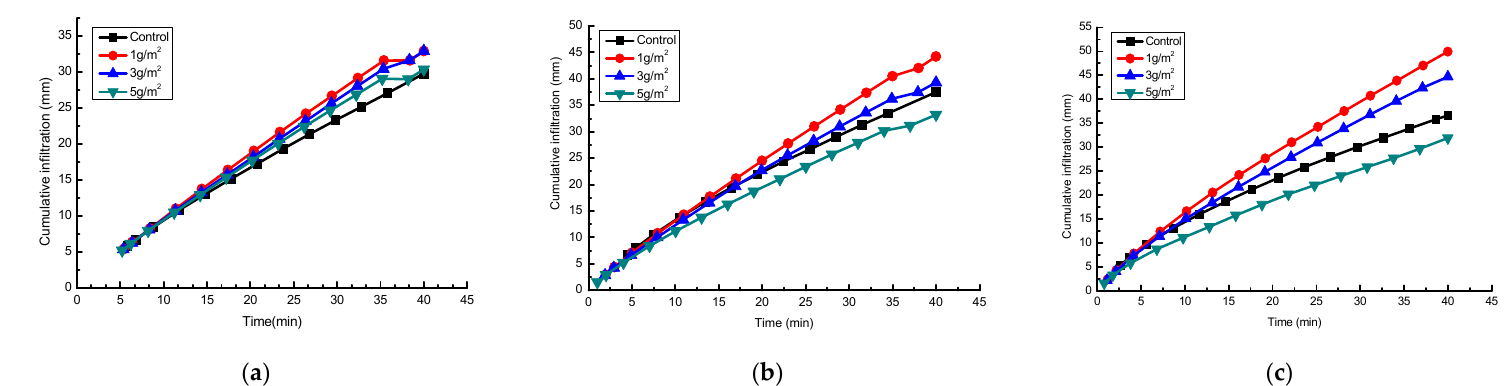
Figure 3. Cumulative infiltration of spraying Jag S under three rainfall intensities. ( a ) 1.0 mm/min; ( b ) 1.5 mm/min; ( c ) 2.0 mm/min.